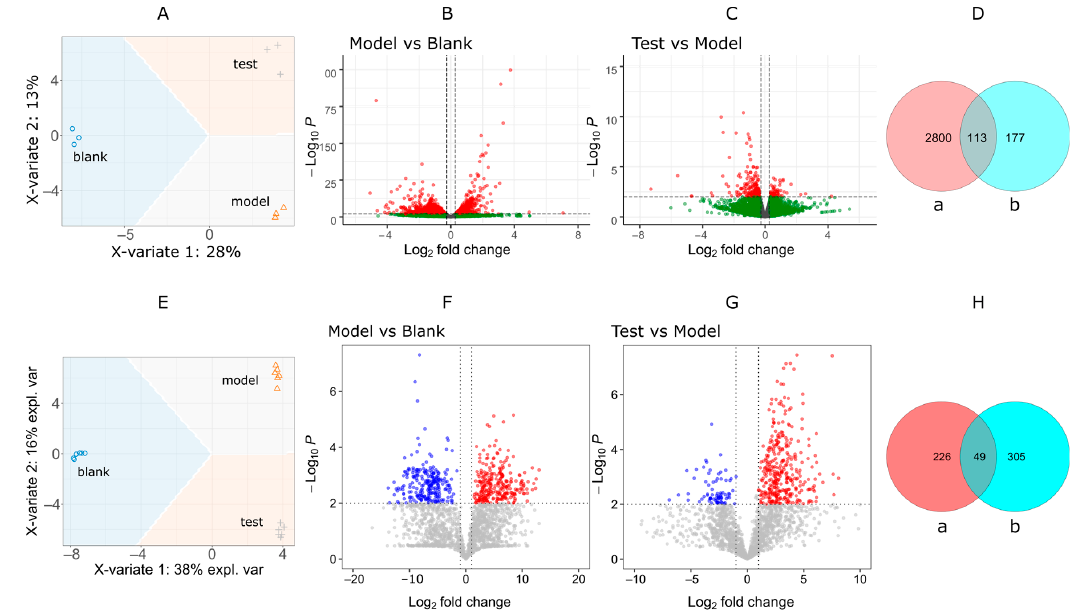
Figure 5. Visual analysis of differentially expressed genes (DEGs) and differential metabolites (DMs). ( A ) sPLS-DA analysis of DEGs. ( B , C ) valcono plot of DEGs ( p < 0.01). ( D ) Venn plots of DEG counts. a, model vs. blank; b, test vs. model. ( E ) sPLS-DA analysis of DMs. ( F , G ) valcono plot of DMs (FC > 2, p < 0.01). ( H ) Venn plots of DM counts. a, model vs. blank; b, test vs. model.